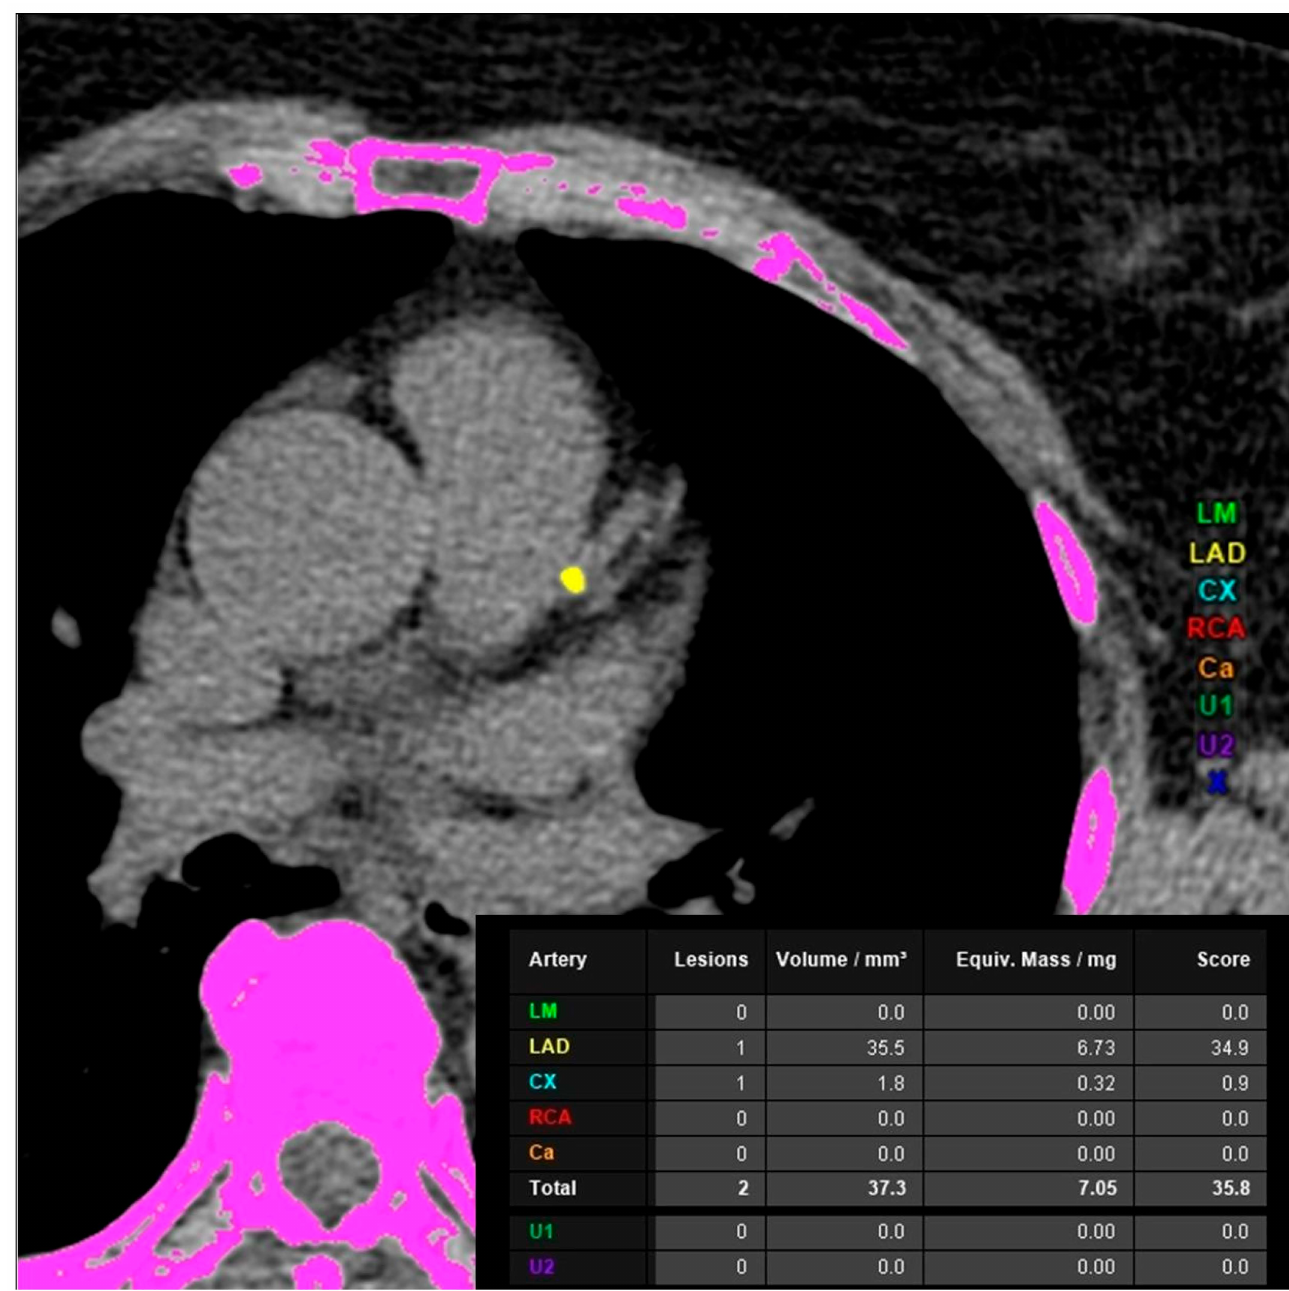
Figure 1. Cardiac computed tomography angiography. Native phase. Coronary artery calcium score assessment—mild risk of significant coronary artery diseases. LM—left main coronary